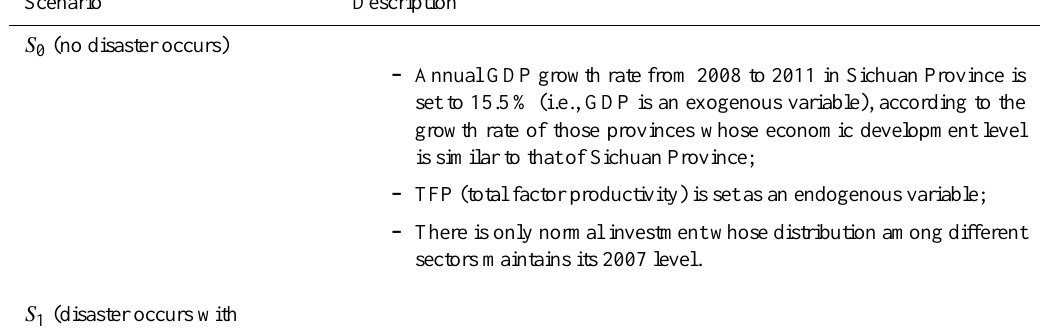
Table 3. Description of